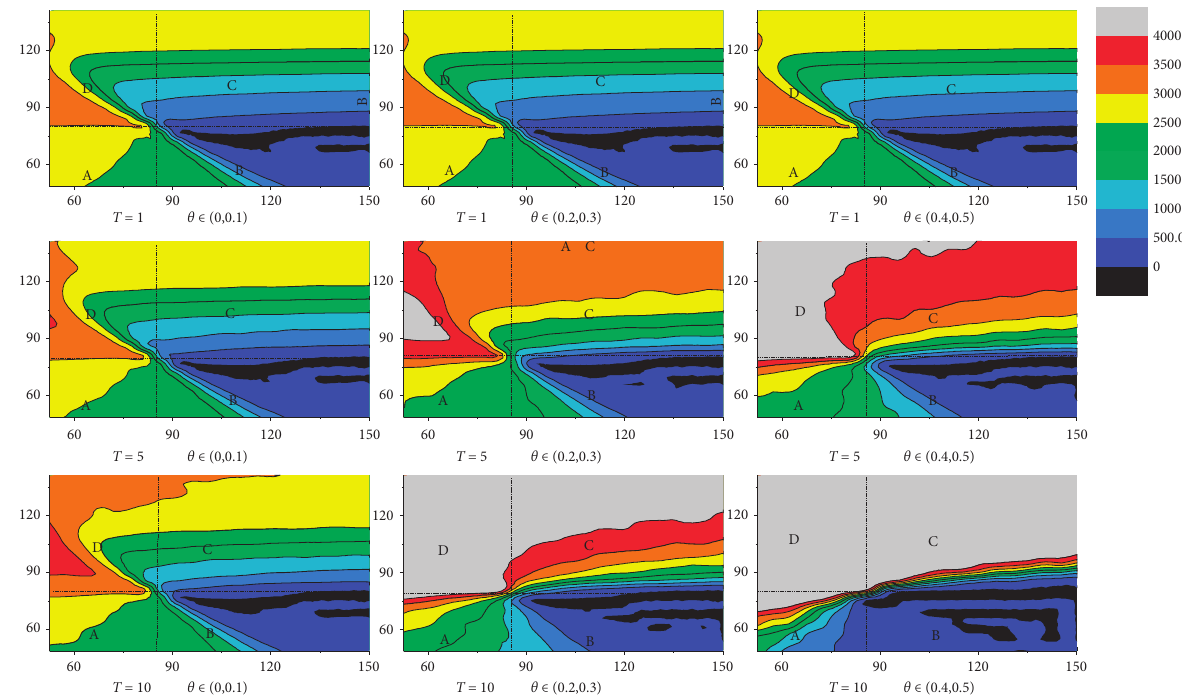
Figure 10: Effectiveness of true decoy strategies in scenarios with different herd